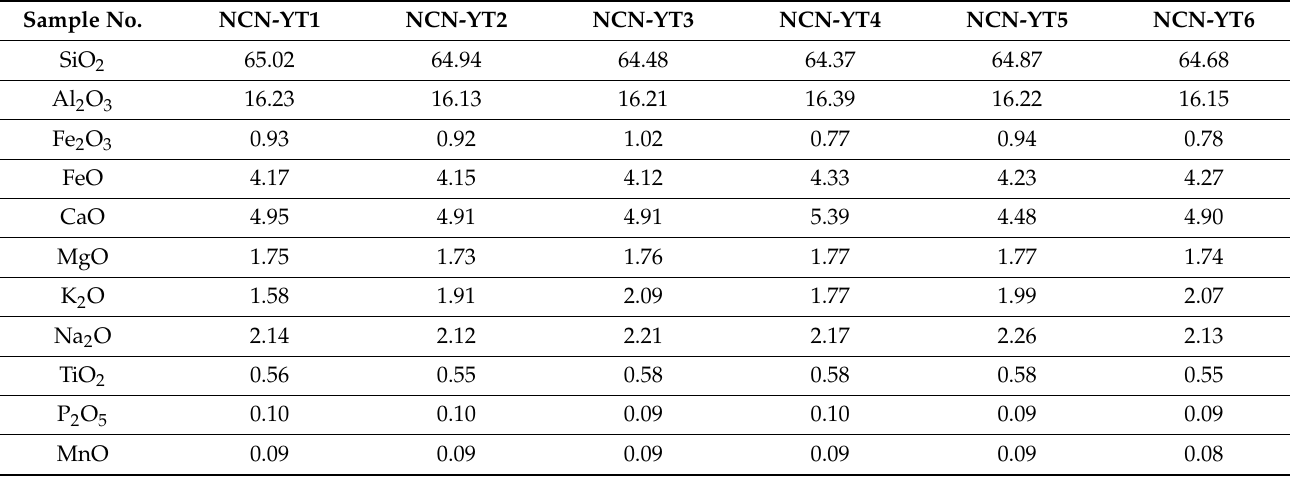
Table 3. Major and trace element analysis result of Nuocang granodiorite (major elements: wt%; trace elements: